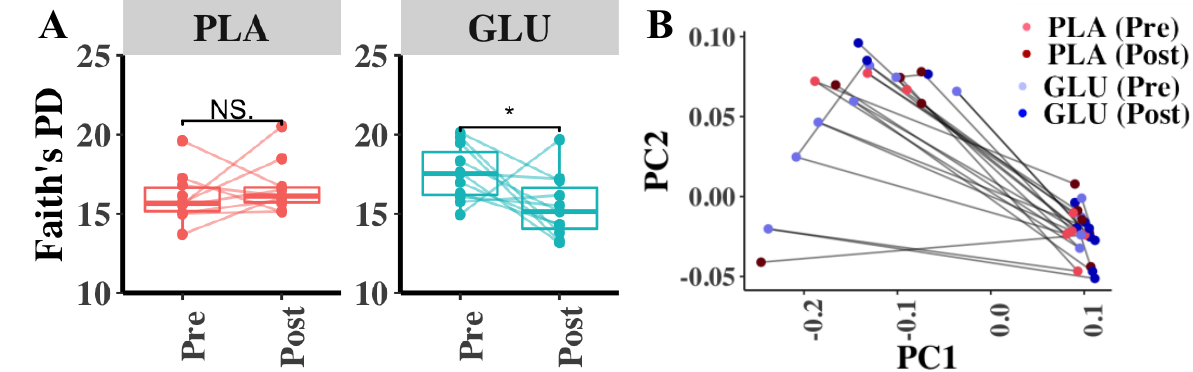
Figure 3. Intestinal microbiota diversity before and after glucosamine consumption. ( A ) Faith’s Phylogenetic Diversity of bacterial contents in fecal samples before and after PLA and GLU consumption, with points representing individual fecal sample communities. Bacterial composition before and after GLU treatment was significantly different (* Student t -test, p < 0.05). ( B ) Principal Coordinates Analysis (PCoA) of bacterial beta-diversity according to the unweighted UniFrac metric. The solid black lines connect the fecal microbiota from one individual at each of the four fecal collection time points. The dots for each condition are color coordinated whereby the light and dark blue dots are the Pre and Post-Supplementation GLU samples, respectively. Similarly, the pink and dark red dots are Pre and Post PLA samples, respectively.